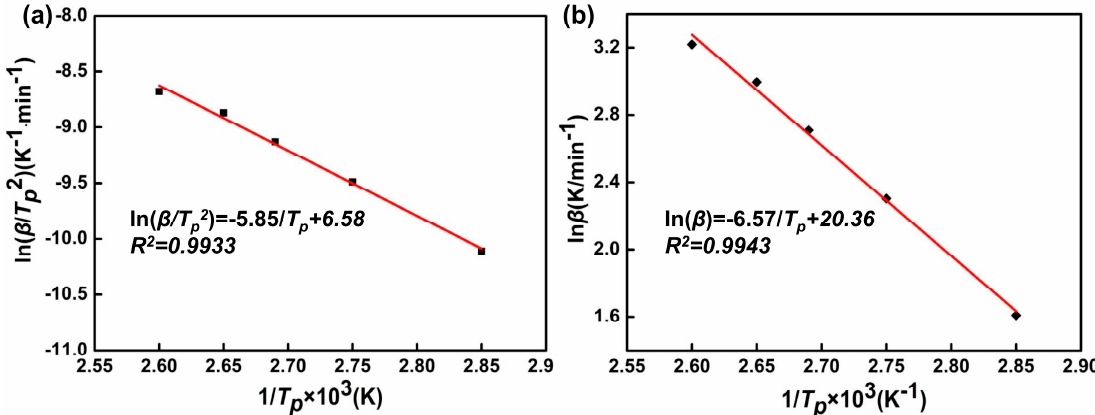
Figure 3. E determination of the phenolic amine/epoxy resin system by ( a ) the Kissinger method and ( b ) the Ozawa ( b )the Ozawa method.